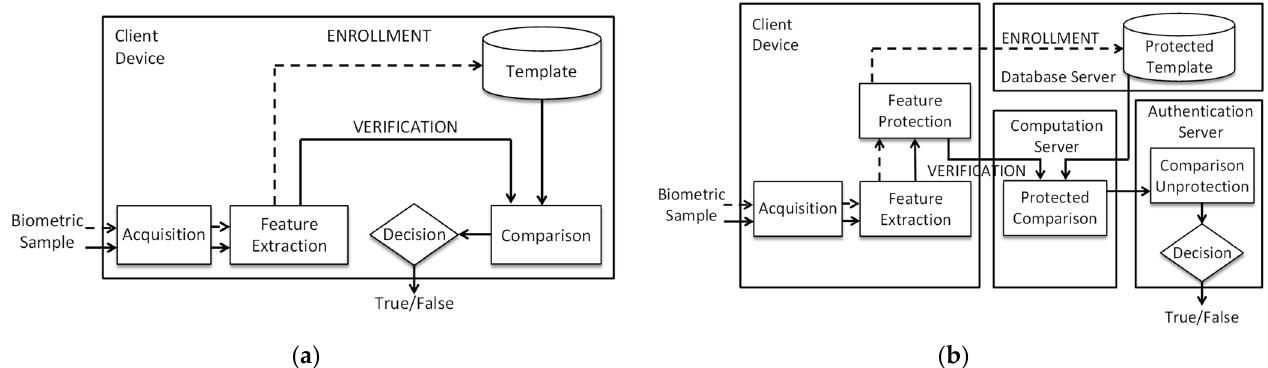
Figure 1. Biometric authentication architectures: ( a ) device-centric, ( b ) protected and non-device- centric.